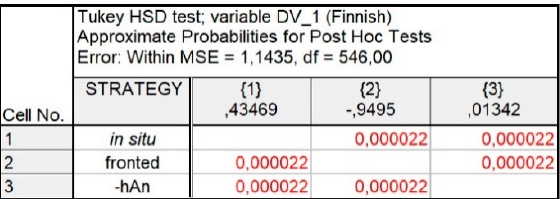
Figure 7. Strategy mean results (Finnish) .